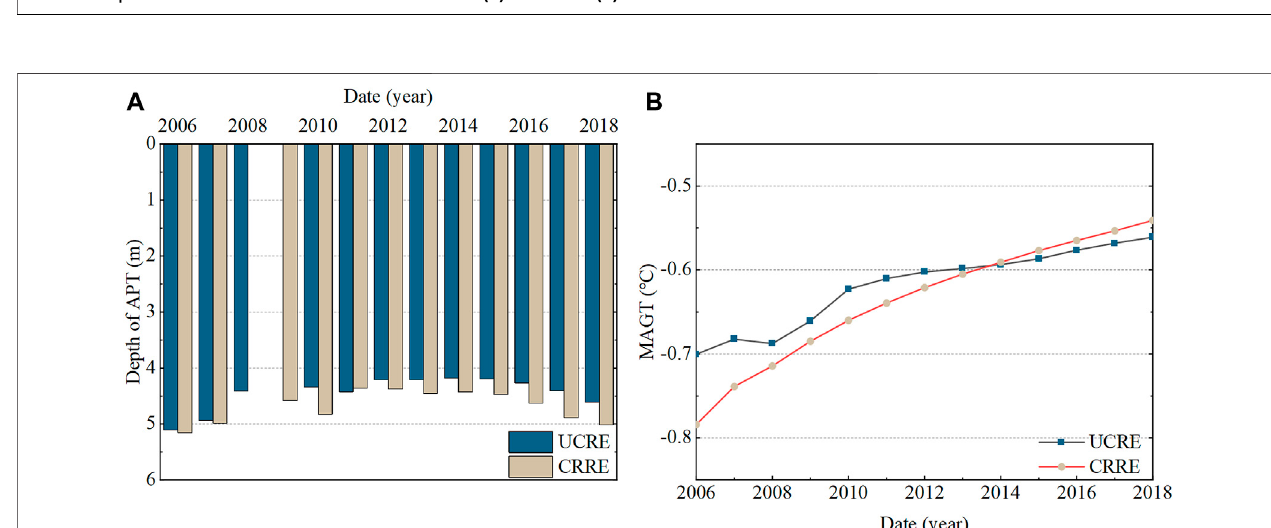
FIGURE 5 | Isotherms under the left shoulder of the UCRE (A) and CRRE (B) .